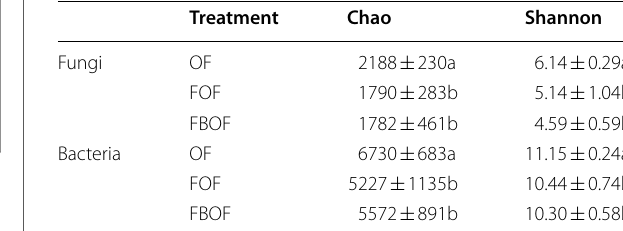
Table 1 Soil microbial diversity indices